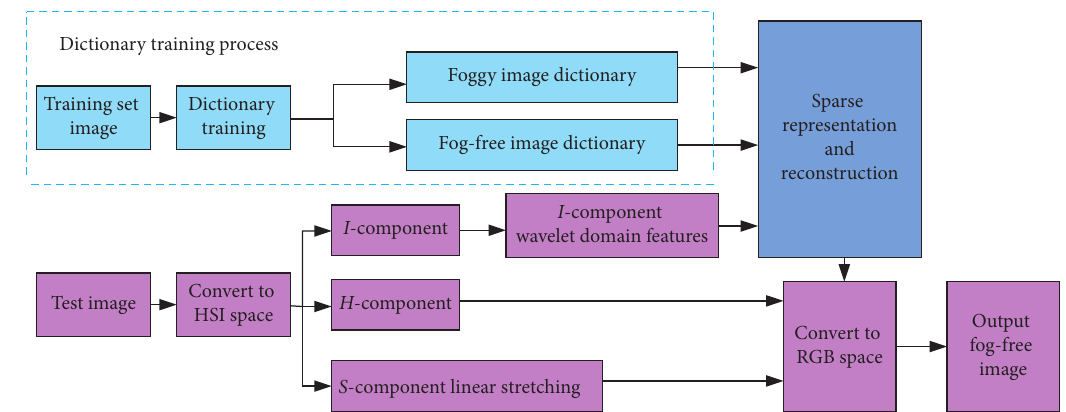
Figure 1: Defogging algorithm framework based on sparse representation.